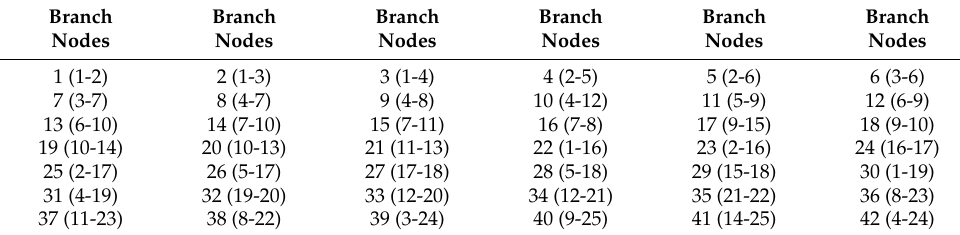
Table 7. Relation among branches and